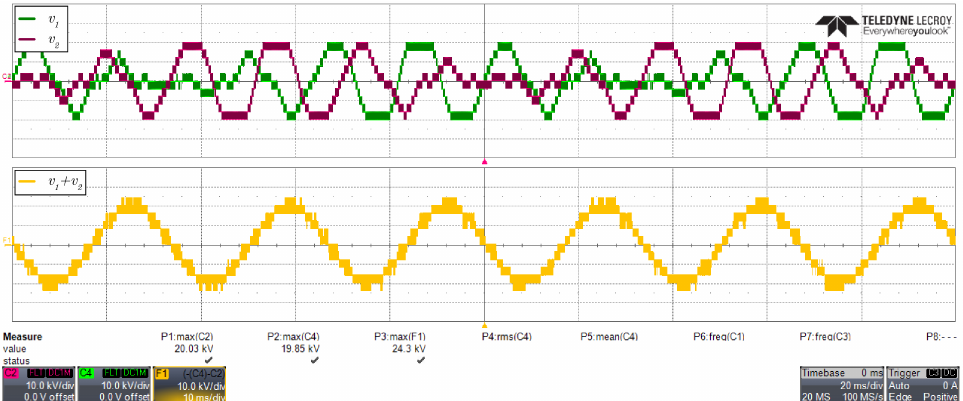
Figure 12. Voltages synthesized by two adjacent Hexverter arms. The sum of both results in the line voltage imposed by the